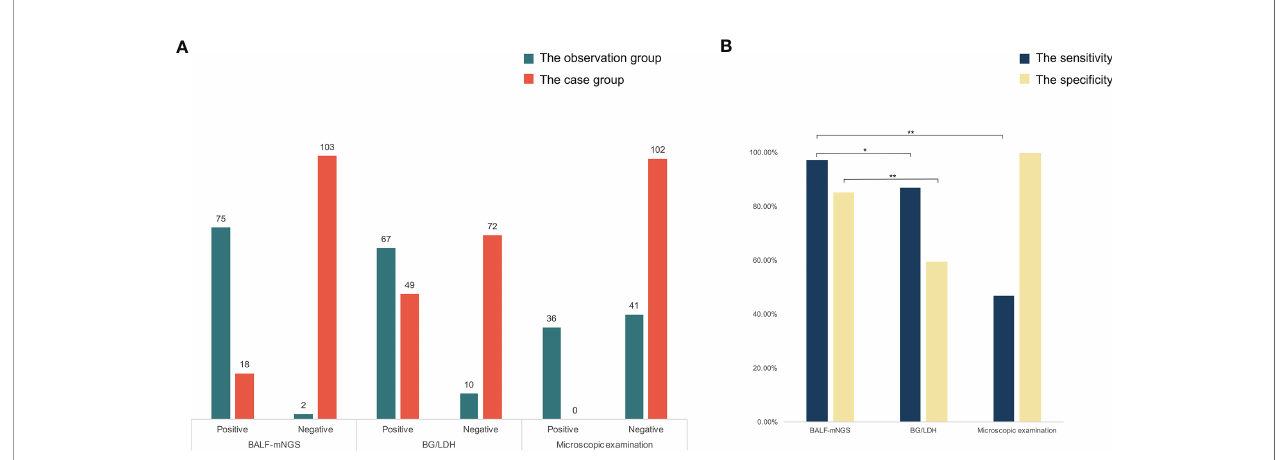
FIGURE 2 | The comparisons of detected results among mNGS, BG/LDH, and microscopic examination. (A) The detected result of each patient of the three methods. (B) The sensitivity and speci fi city of the three methods. The sensitivity and speci fi city of mNGS were signi fi cantly higher than the other two methods (p<0.05). p <0.05 was marked as *, and p <0.01 was marked as **.